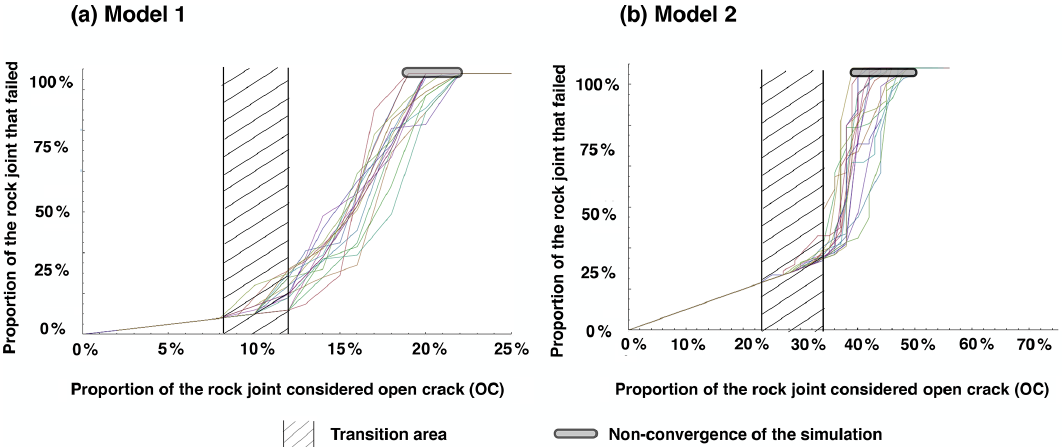
Figure 6. Propagation of rock bridge failure for models 1 and 2 considering Scenario 3 in the case of randomly introduced new OC